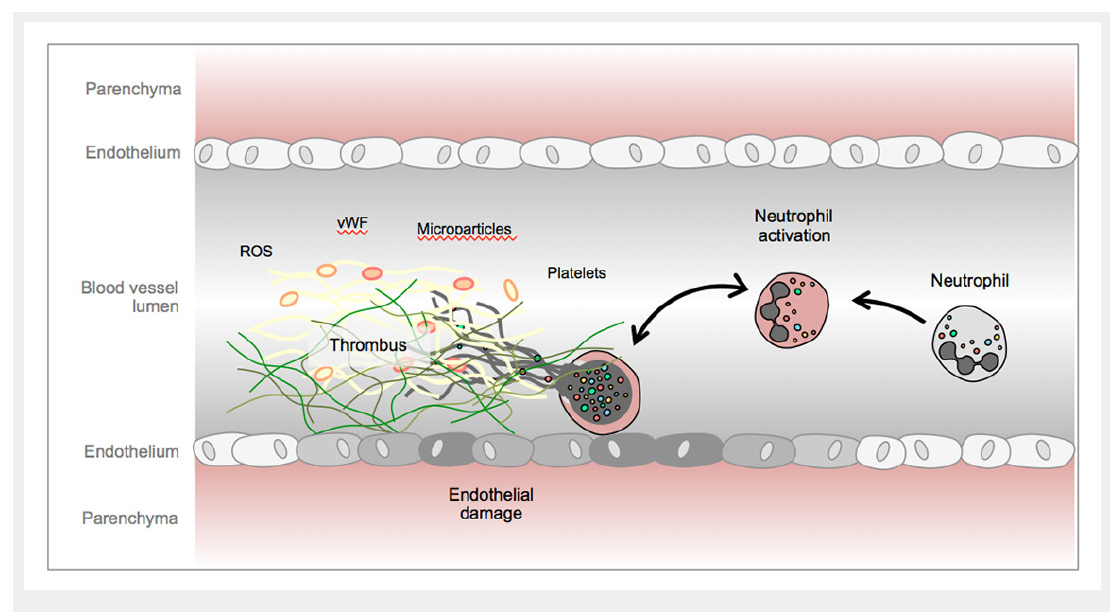
Figure 4 Endothelial cell damage, von Willebrand factor and activated platelets promote neutrophil extracellular trap formation and thrombosis in the vasculature. ROS = reactive oxygen species; vWF = von Willebrand